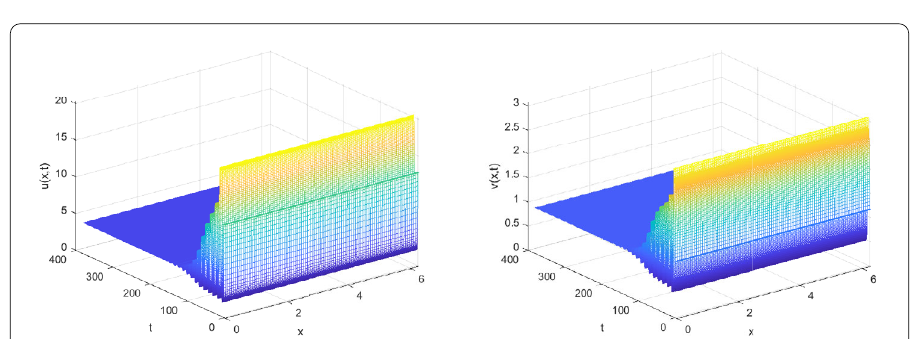
Figure 11 τ = 3.8 < τ 0 0 and the initial condition is (12.71,1.17). P ∗ = ( u ∗ , v ∗ ) is locally asymptotically stable